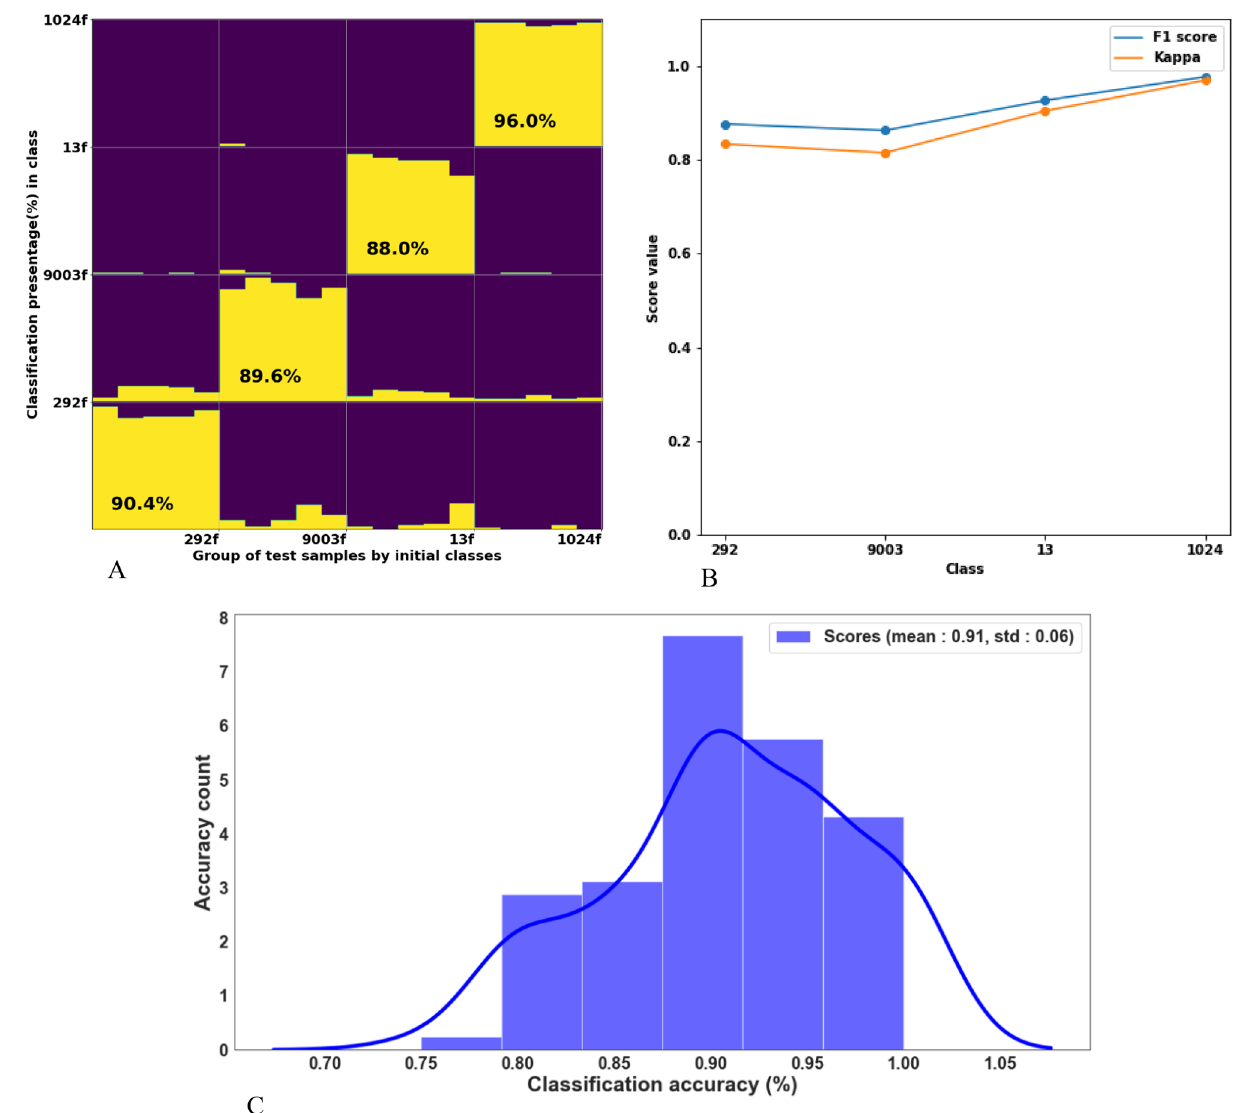
Figure 2. Classification of fresh pips, using a random train set of fresh pips. ( A ) Accumulative accuracy of LDA classification after performing 100 training and 100 independent test evaluations for each pip. At each run, the ten random pips from the assemblage were selected as a random training group, and the remaining five pips were classified independently; ( B ) F1 and Kappa s cores of random fresh vs fresh data splits with 100 iterations, ( C ) Classification accuracy histogram—100 training [10 samples] and tests [5 samples], gaining mean accuracy of 91%. Cabernet